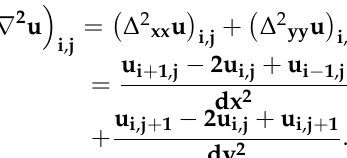
Figure 5. A schematic node-ordering representation for a two-dimensional finite-difference grid [23].